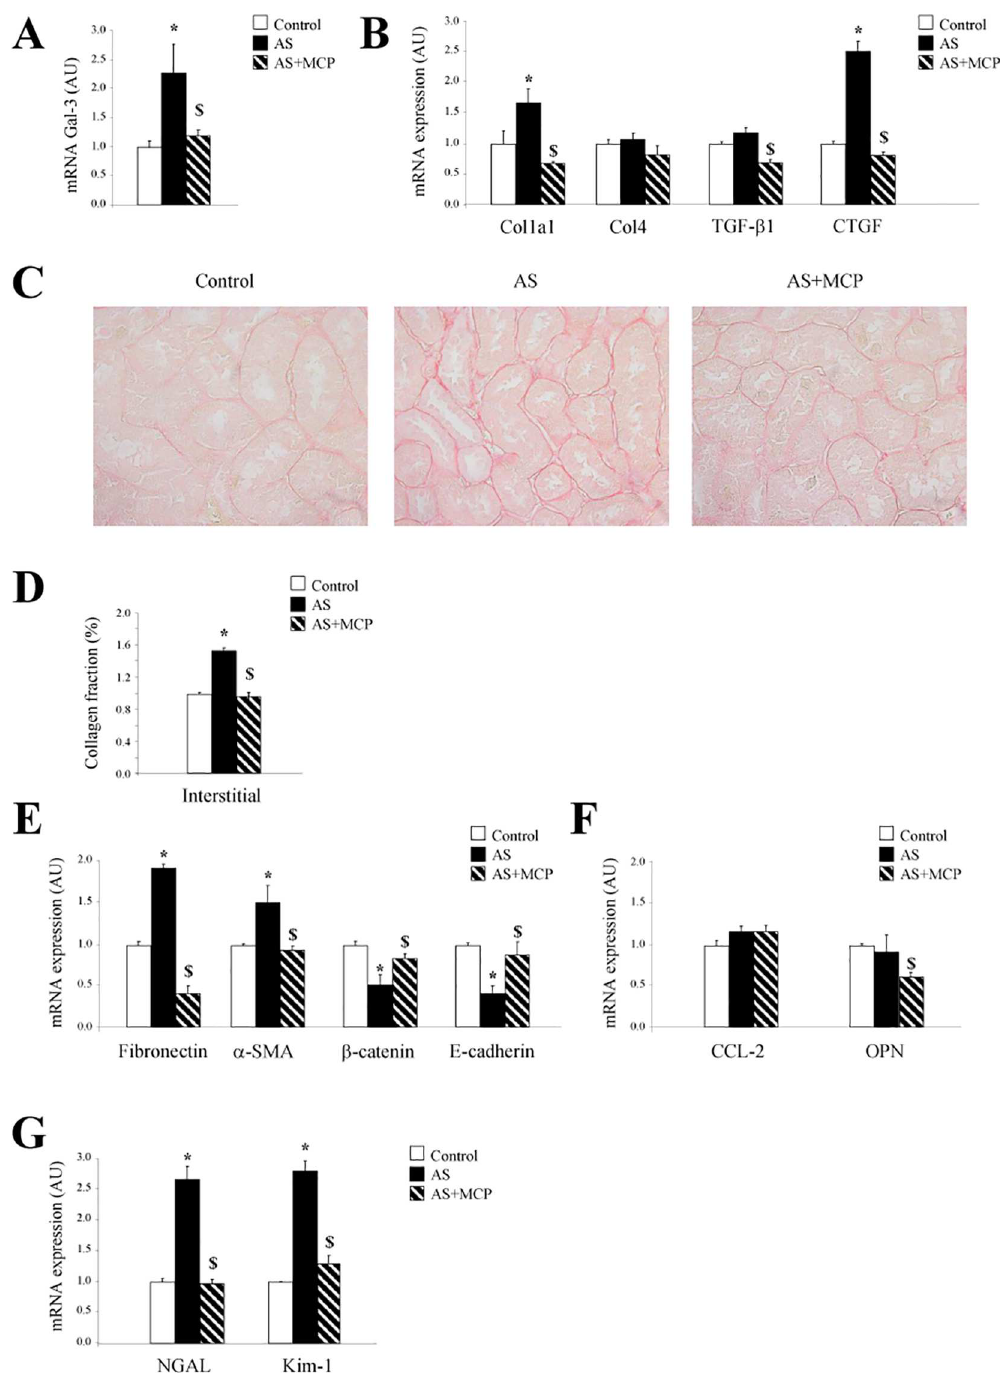
Fig 2. Effects of pharmacological inhibition of Gal-3 on renal damage in AS rats. Expression of Gal-3 (A) . Quantification of fibrotic markers expression( B ). Representative microphotographs of renal sectionsstained with Sirius red ( C ). Quantification of tubulointerstitial fibrosis ( D ). Expression of epithelial-mesenchymal transition molecules( E ). Expression of inflammatory mediators (F) . Expression of kidney damagemarkers (G) . Magnification of the microphotographs40x. Histogrambars represent the mean ± SEM of each group of animals(n (cid:21) 7 per group) in arbitrary units or as a percentageof stainingnormalized to HPRT and β -actinfor cDNA. * p < 0.05vs. control group; $ p < 0.05vs AS